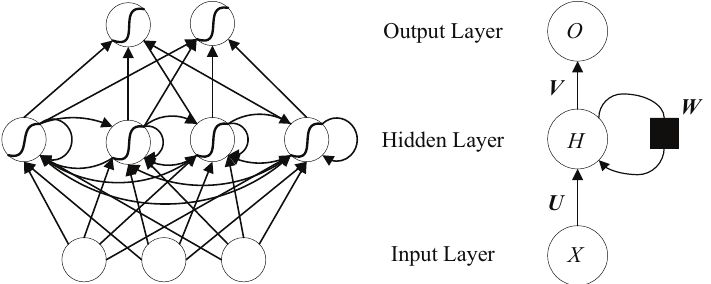
Figure 6. The network structure of Recurrent Neural Network